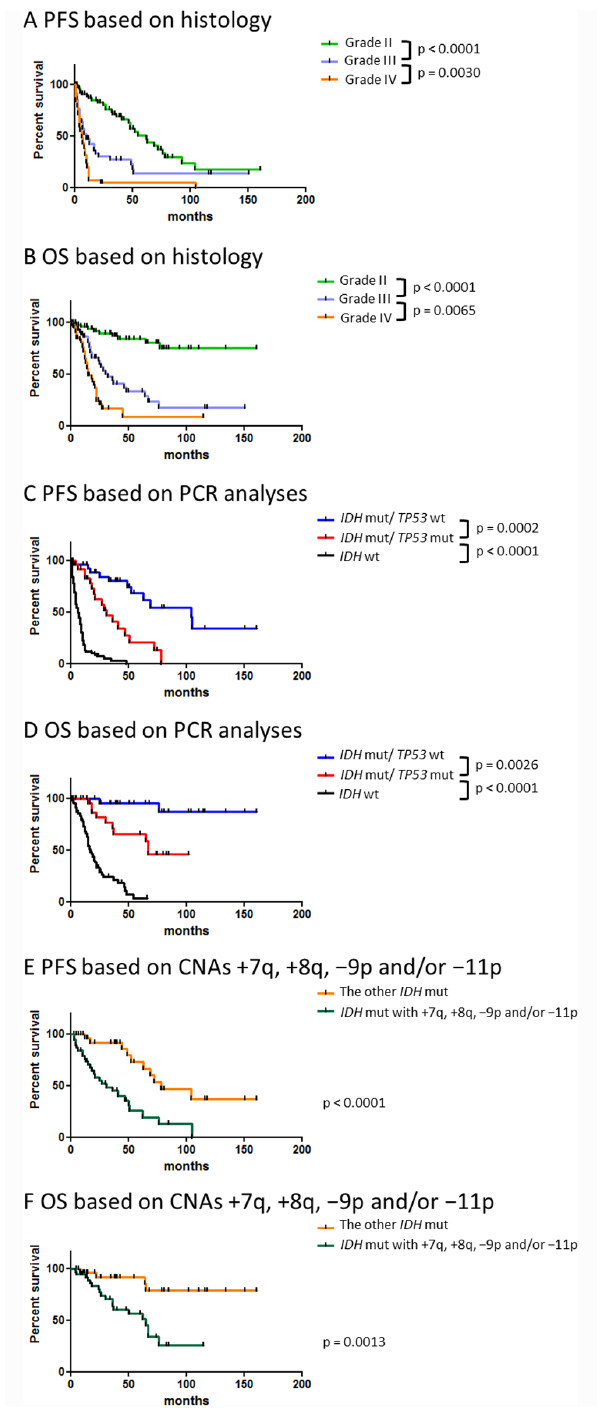
Fig 1. Kaplan – Meier curves of progression-free survival (PFS) according to subgroups. A comparison of PFS and overall survival (OS) according to (A and B, respectively) pathological (n = 171) and (C and D, respectively) genetic classification (n = 158). Kaplan – Meier curves comparing PFS (E) and OS (F) associated with IDH mutant gliomas harboring CNAs +7q, +8q, − 9p, and/or − 11p with the PFS and OS of other IDH mutant gliomas (n = 73). Only patients who underwent an initial surgical intervention were included in these analyses. Abbreviations: mut; mutation, wt; wild-type.